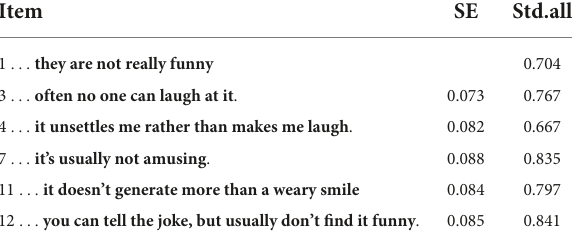
TABLE 2 Standard errors and standardized factor loadings of the failed humor scale. Item SE Std.all